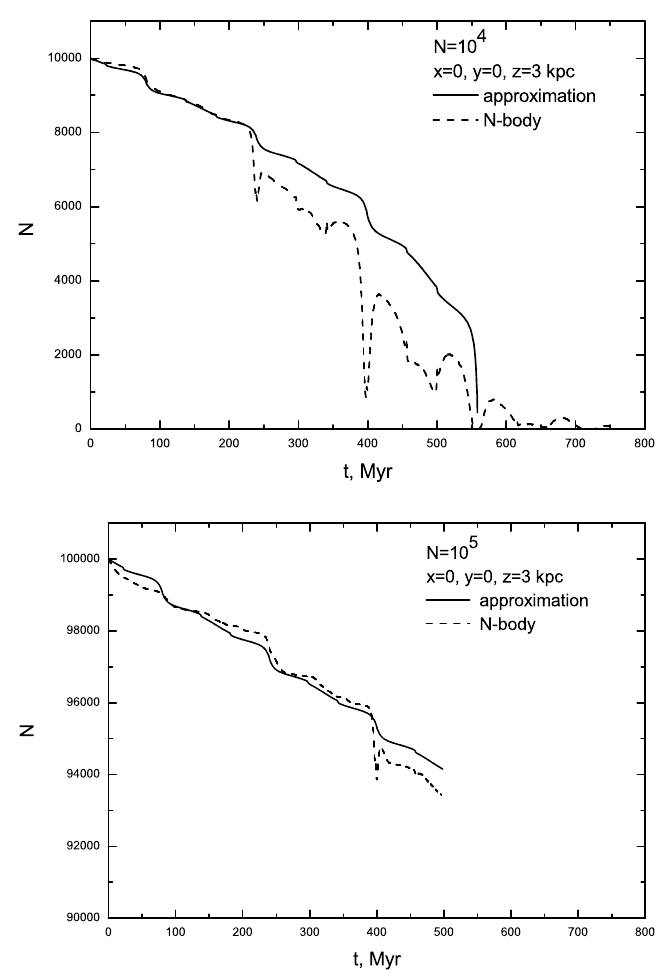
Fig. 5. Comparison of numerical calculations and theoretical predictions by